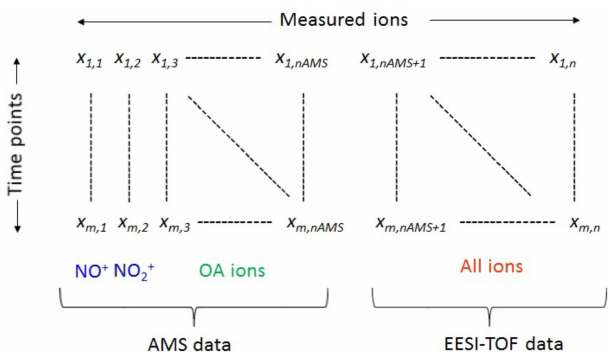
Figure 1. Schematic of the combined EESI-TOF and AMS input data matrix ( X ) for cPMF. Matrix dimensions for the summer and winter datasets are provided in Table